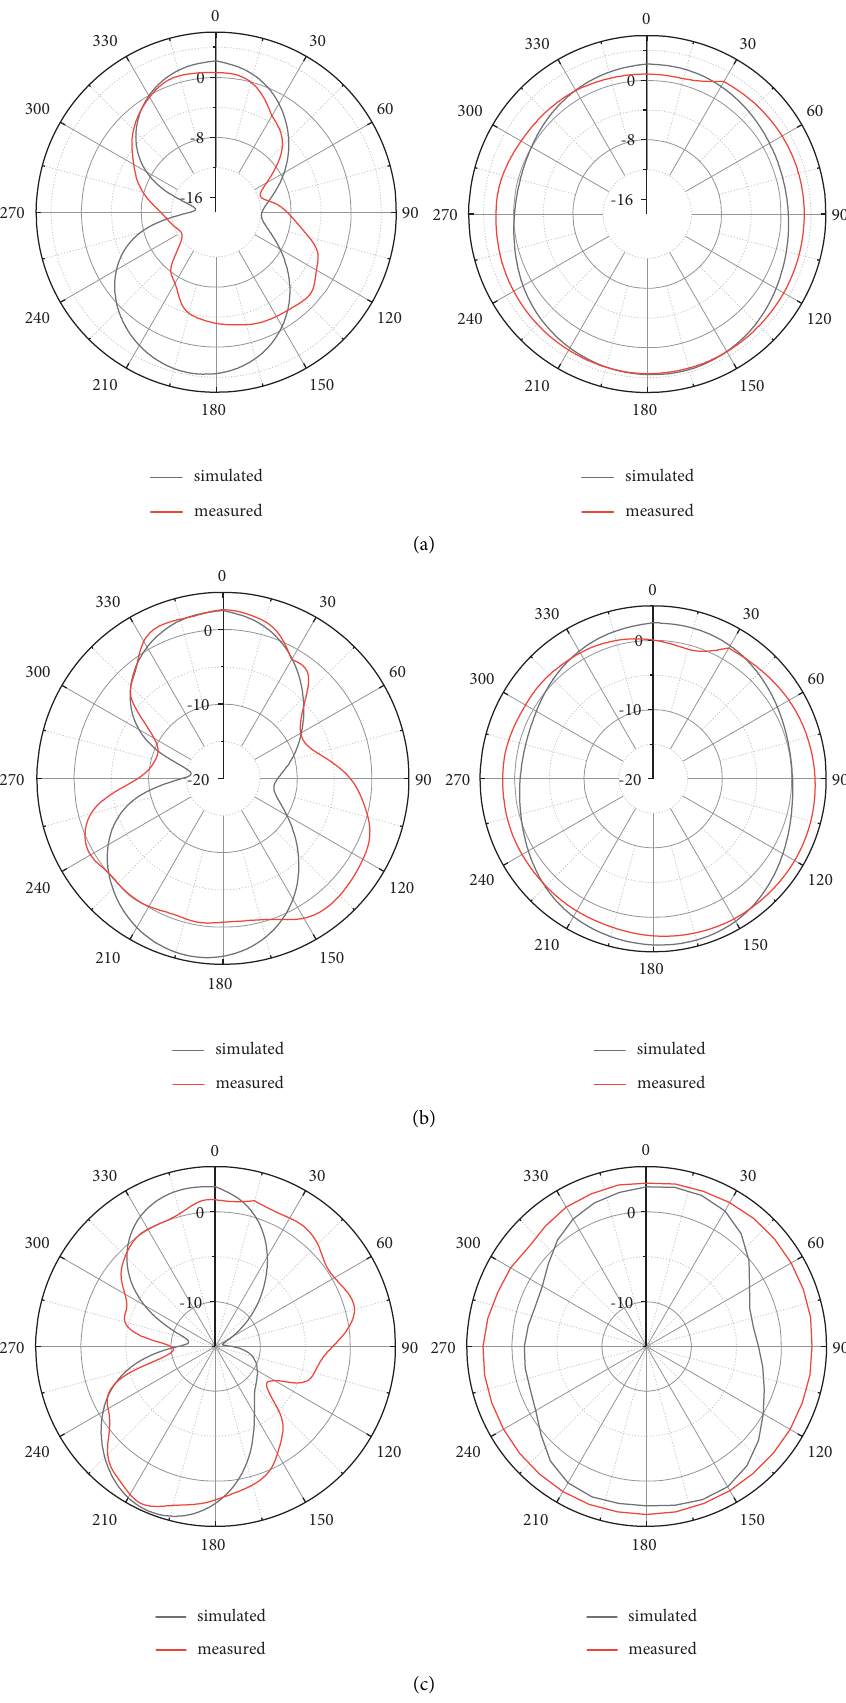
Figure 12: Free space comparison of simulated and measurement radiation pattern in the YOZ-plane and XOZ-plane. (a) 4 GHz. (b) 6.5 GHz. (c)